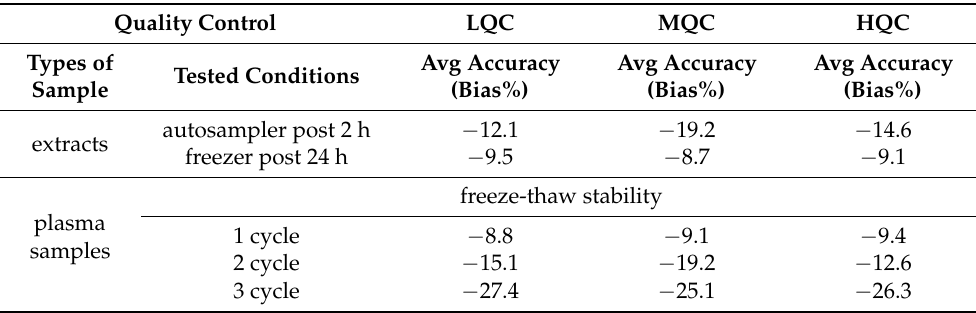
Table 8. Stability of VBR at different storage conditions. In our study, we tested both the extracts and the plasma samples (according to our routine